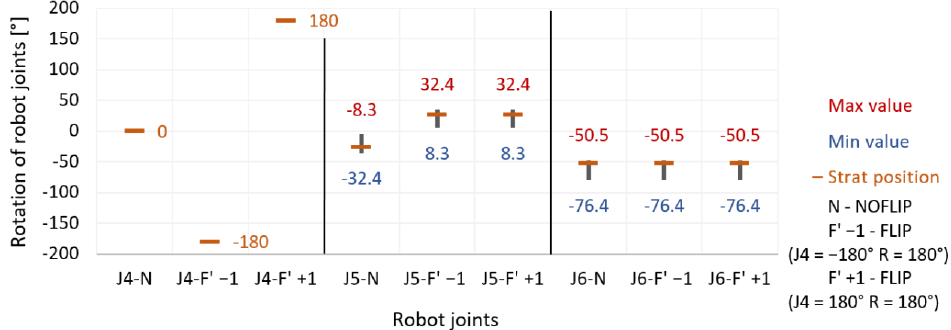
Figure 15. Position of robot joints J4, J5, and J6 when measured in the plane parallel to the base of the robot.